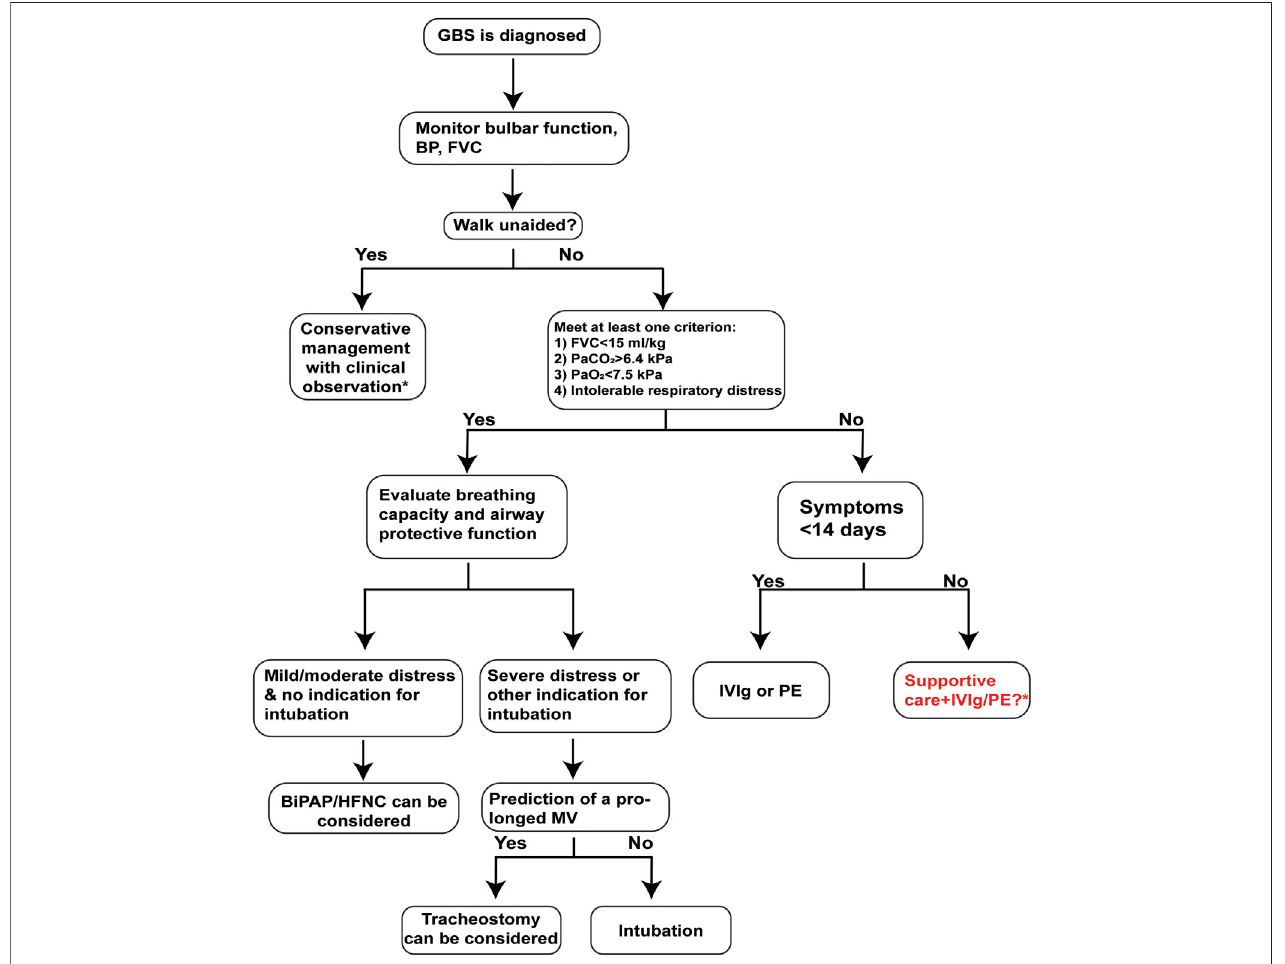
FIGURE 4 | A pragmatic decision-making work fl ow for the intensive care and treatment of GBS. Clinical decision on MV is closely correlated to the prognosis of GBS patients.Thestrictscreeningstepsrelyondynamicmeasurementsofdiseaseprogressionandrespiratoryfunctions,whicharevitalfortheimplementationofproperindividualistic therapeuticstrategies.Adecisionfornoninvasiveventilation,trachealintubationwithMV,ortracheostomyreliesontherespiratorycapacityandairwayprotectioncapacityofGBS patients.*Treatmentdilemmasoccurinpatientswithrelativelymildsymptomsorwhentheplateauofweaknesswasmorethan2 weeksbefore.Abbreviations:BiPAP,bilevel positive airway pressure; BP, blood pressure; EGRIS, Erasmus GBS respiratory insuf fi ciency score; FVC, forced vital capacity; GBS, Guillain – Barré syndrome; HFNC, high- fl ow nasal cannula; ICU, intensive care unit; IVIg, intravenous immunoglobulin; MV, mechanical ventilation; PE, plasma exchange.